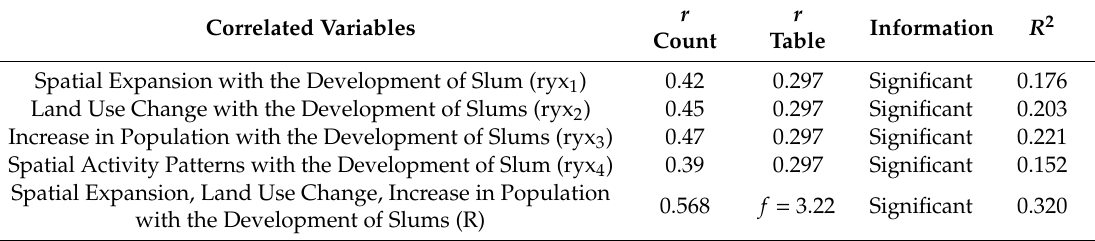
Table 5. Summary of associative hypothesis testing.